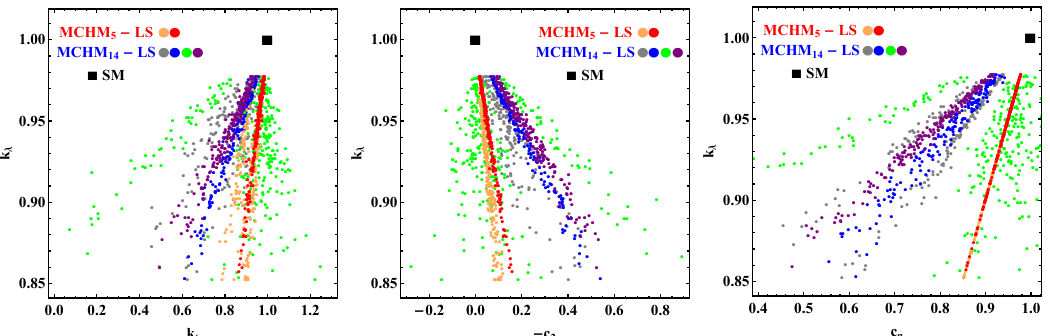
Figure 20 . Values of some selected EFT parameters in the low scale scan of the MCHM 5 and the MCHM 14 parameter spaces. The colors indicate the different Regions in each model (I and II for the MCHM 5 and I, II, III and IV for the MCHM 14 , in that order). The SM is represented by the black square.